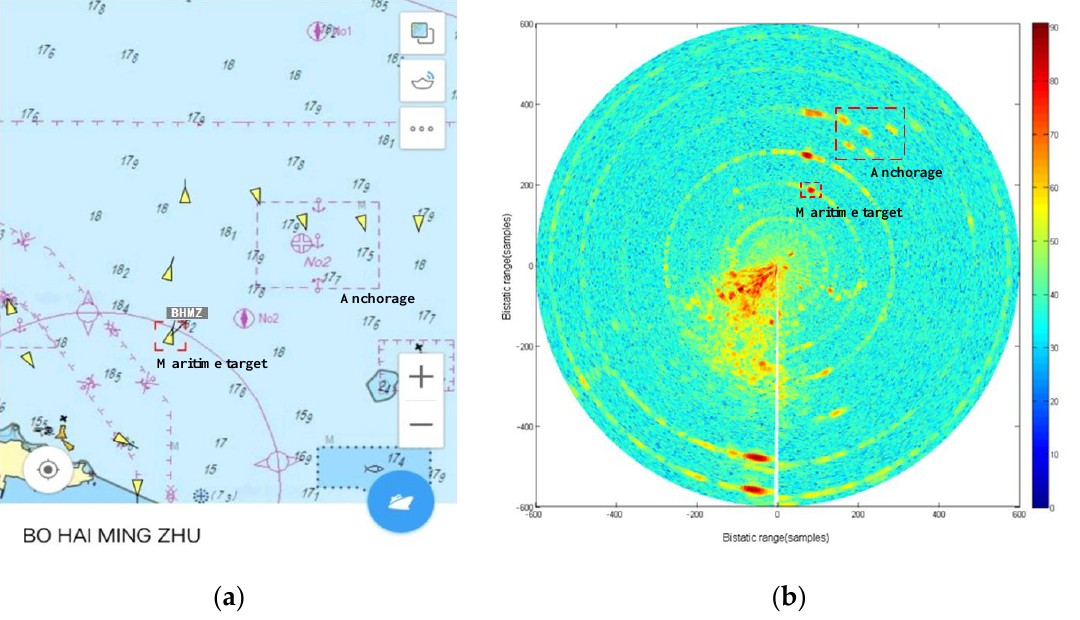
Figure 17. Comparison of the results between the AIS map and HBR map of maritime targets (T1 time: 10:32:13, range: 29.25 km): ( a )AIS map; ( b ) HBR map.